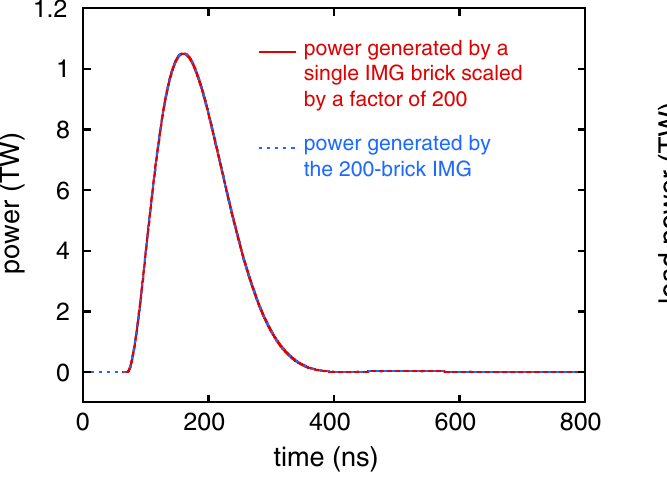
FIG. 10. Simulated electrical-power time histories generated by FIG. 9. Simulated electrical-power time histories generated by the ten-stage IMG illustrated by Fig. 4. The red trace assumes the one of the bricks of the IMG illustrated by Fig. 4, and the 200- IMG ’ s impedance-matched transmission line has a stepped brick IMG. The power generated by a single brick is that which impedance profile, as suggested by Fig. 5(a). The blue trace would be delivered by the brick to a matched-impedance load; assumes a piecewise-linear impedance profile, as suggested by i.e., a load with impedance Z . The power generated by the 200- b the conical center conductor illustrated by Fig. brick IMG is that which would be delivered by the IMG to a matched-impedance load; i.e., a load with impedance Z . IMG